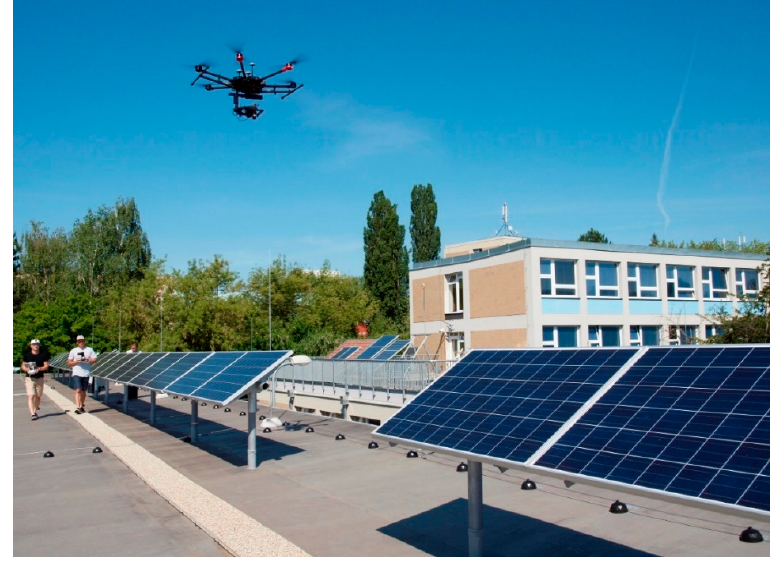
Figure 1. Photovoltaic (PV) power plant and drone during temperature monitoring.